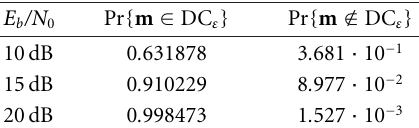
Table 1: Probability of being in the DC. E /N b